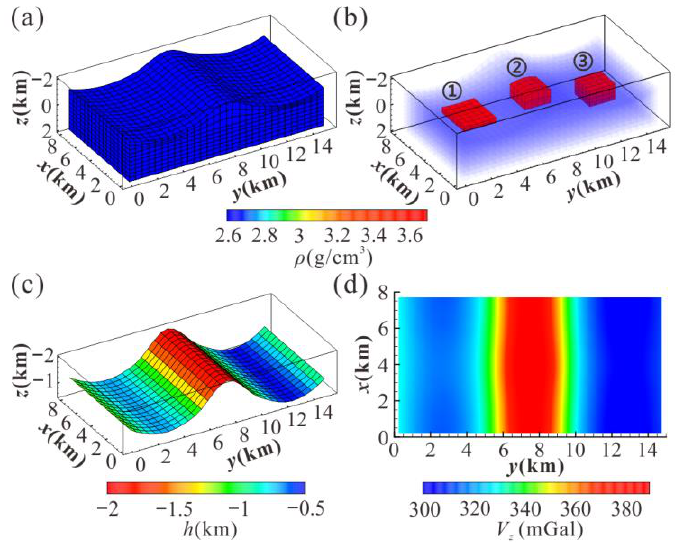
Figure 5. ( a ) Model division; ( b ) real density model; ( c ) topographic relief; ( d ) observation